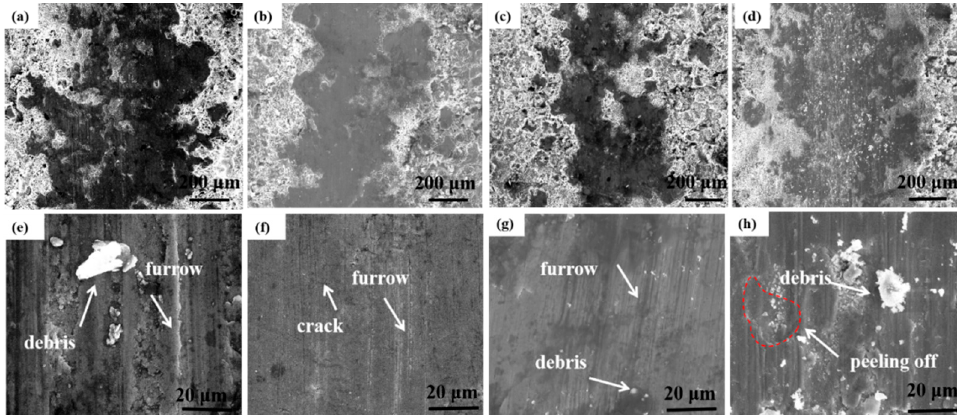
Figure 8. Wear marks of FeCoNiCrMo 0.2 high entropy alloy coating sprayed by plasma at different currents under 10 N load ( a , e ) 250 A, ( b , f ) 350 A, ( c , g ) 450 A, ( d , h ) 550 A.